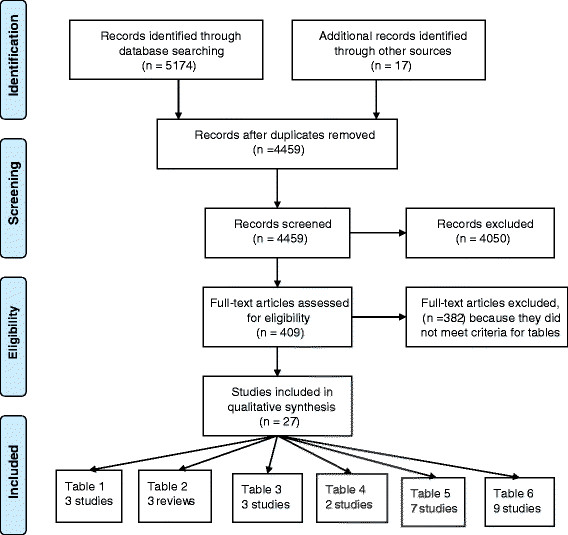
PRISMA flow chart.